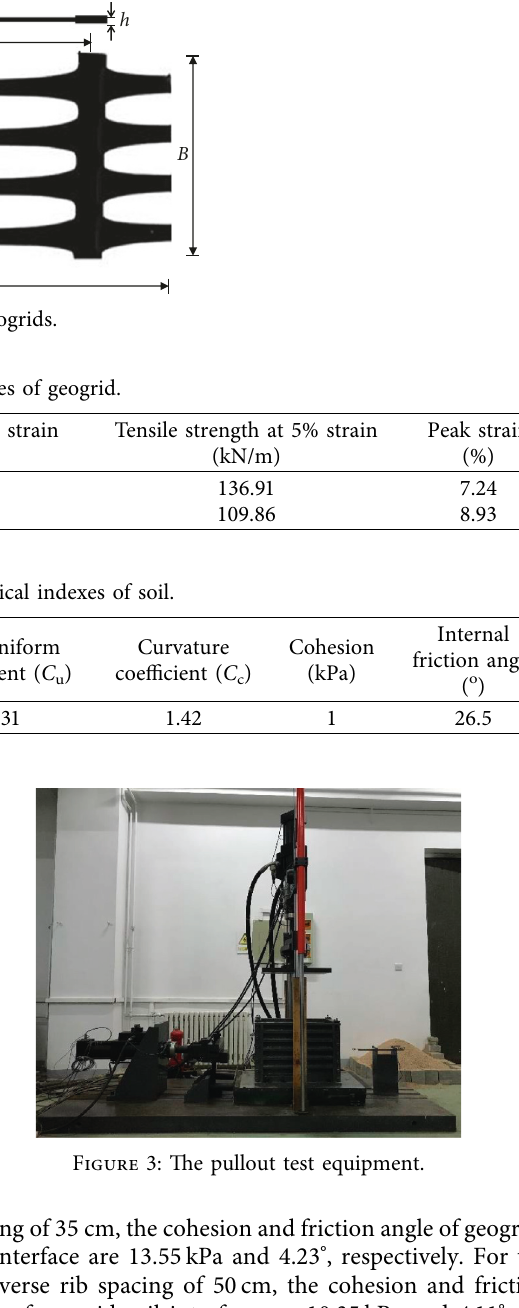
Figure 2: The soil grading curve.